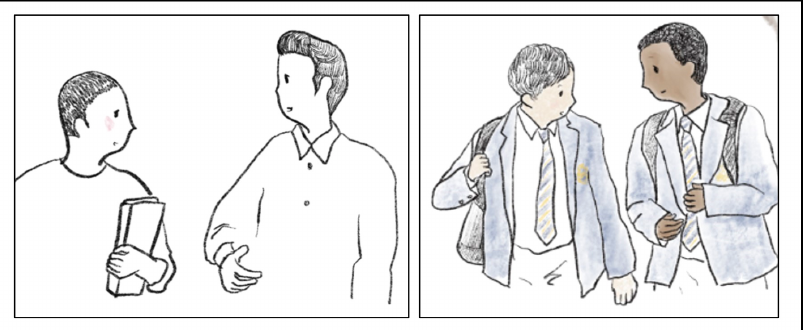
Figure 7. Examples of school-related illustrations.